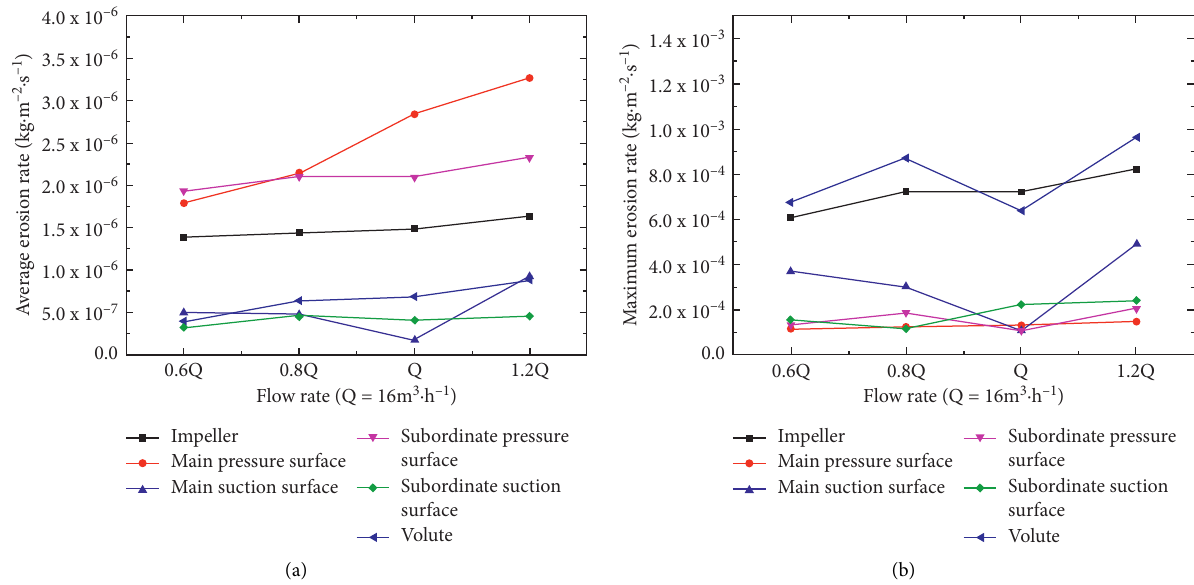
Figure 7: Comparison of wear rate of different parts at different flow rates. (a) Average wear rate; (b) maximum wear rate.